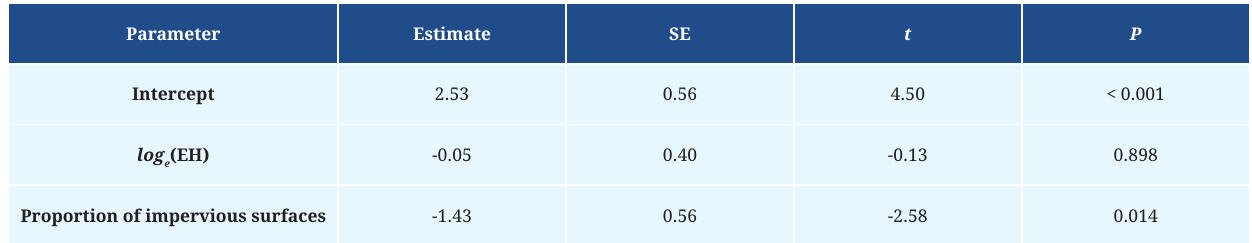
TABLE 1 | Relationship between rarefied species richness and environmental heterogeneity (EH) and the proportion of impervious surfaces assessed with an ordinary least squares model. EH consists of distances to a median value estimated from environmental data. The proportion of impervious surfaces was a proxy for urbanization. SE: standard-error.